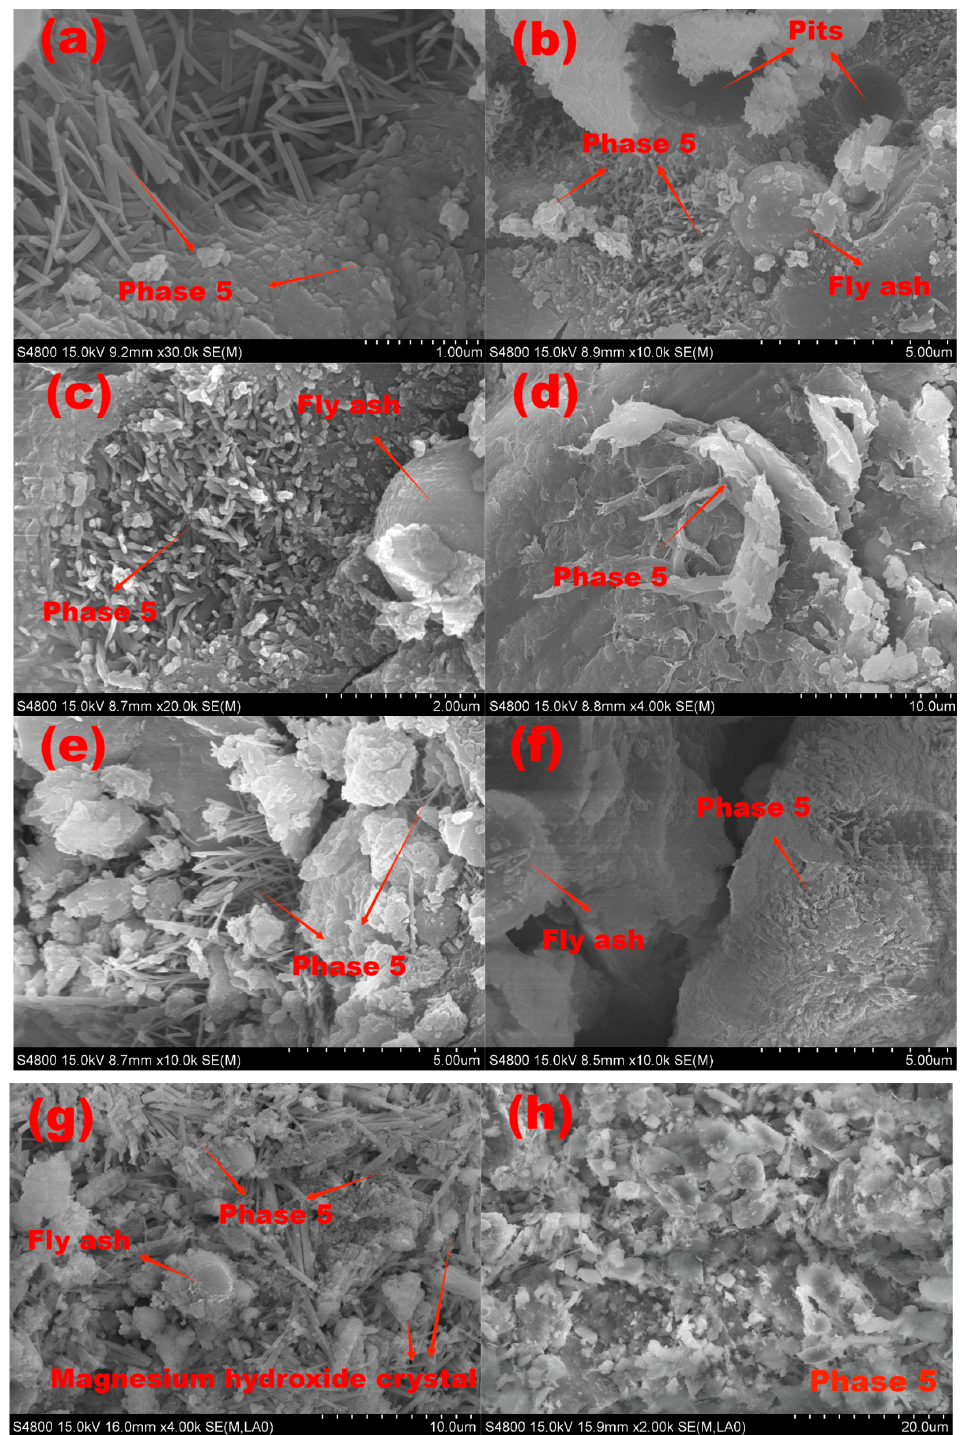
Figure 15. SEM images of modified MOC. Not soaked in water: MOC reference sample ( a ); F 20 -MOC ( b ); S 2 -FMOC ( c – e ); and S 3 -FMOC ( f ). Water immersion: S 2 -FMOC ( g , h ).